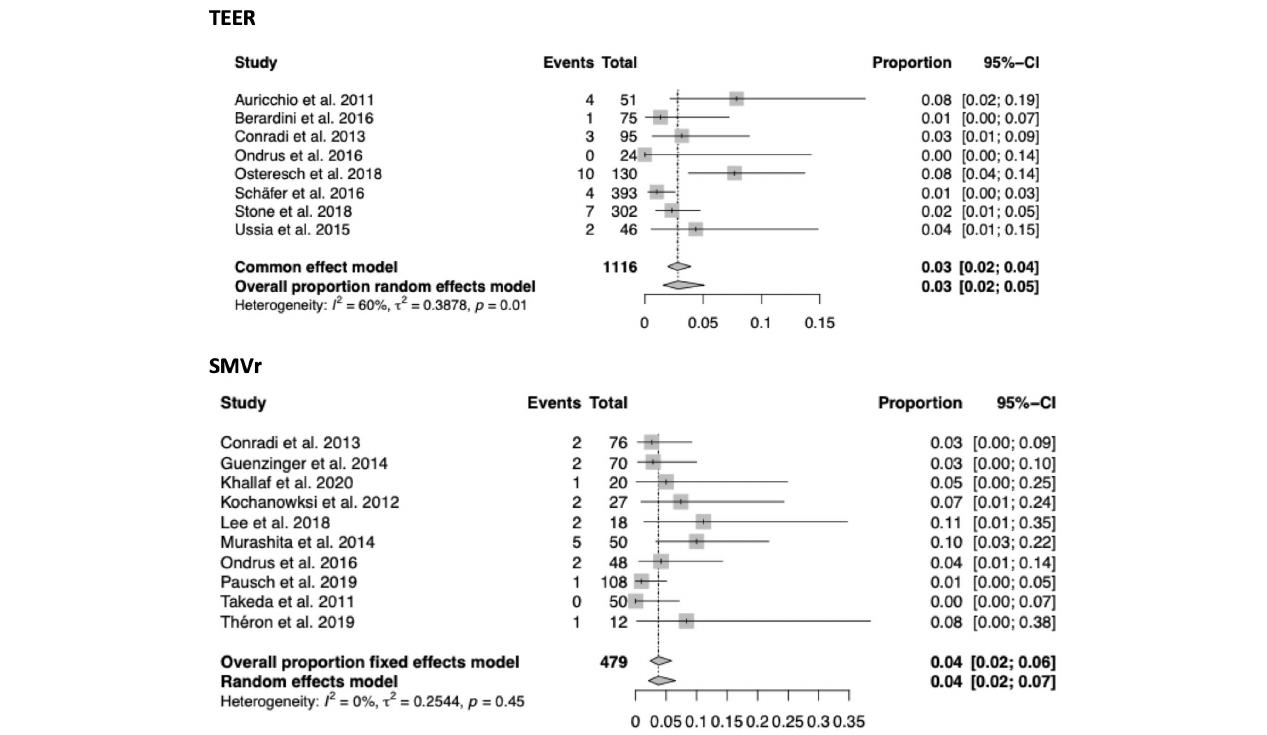
FIGURE5 Forrest plots of the comparison between TEER and SMVr for 30-day cardiac death. TEER, transcatheter edge-to-edge repair; SMVr, surgical mitral valve repair.